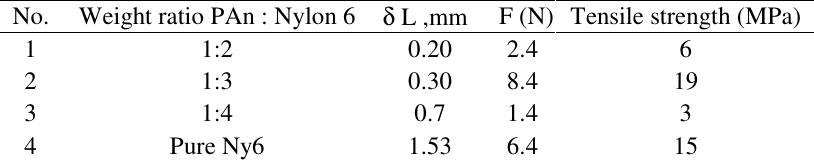
Table 2 . Mechanical properties of PAn /Nylon 6